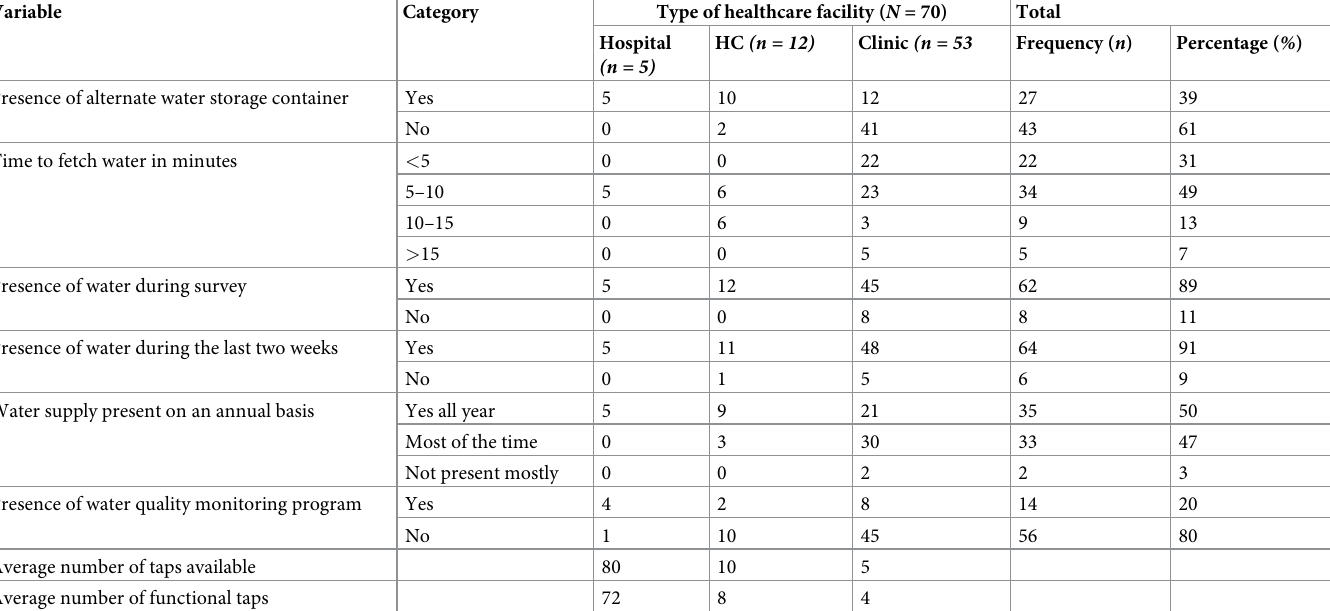
Table 2. Water supply facilities in healthcare facilities of Northeastern Ethiopia from July to August